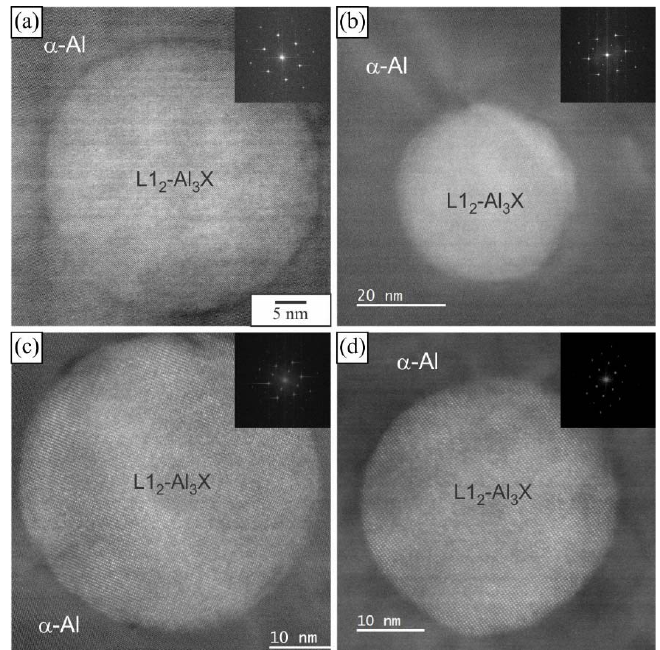
Figure 9. The results of analytical TEM of a particle with the L1 2 structure. After homogenization: ( a ) 6086-Sc, ( b ) 6086-ScY; and after homogenization and heat treatment at 400 ◦ C for 5 h: ( c ) 6086-Sc and ( d )